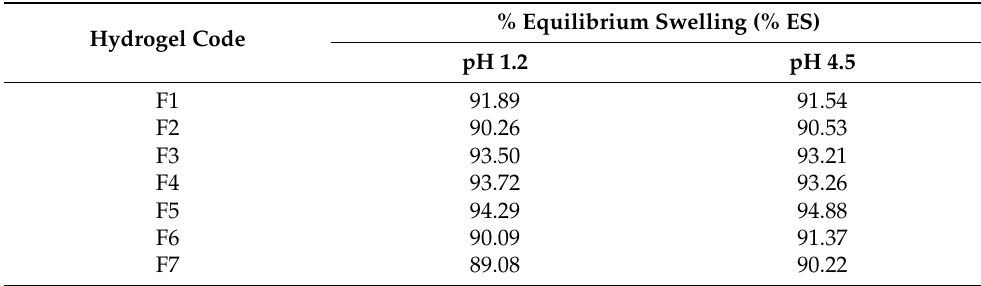
Table 1. Percentage of equilibrium swelling of AAM-based hydrogels at pH 1.2 and